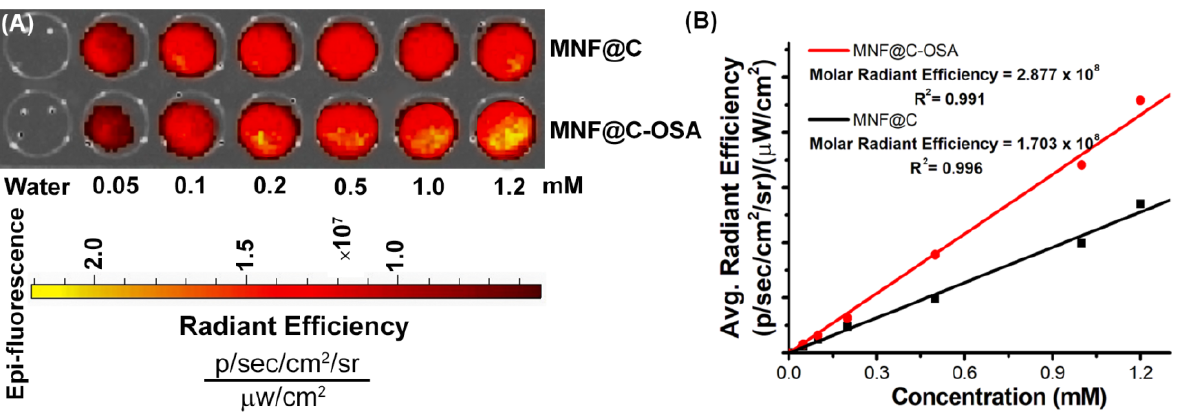
Figure 5. ( A ) IVIS-based fluorescent phantom images of MNF@Cs and MNF@C-OSAs at increasing concentrations. ( B ) The fluorescence image intensities were plotted against concentrations to calculate the molar radiant efficiencies.